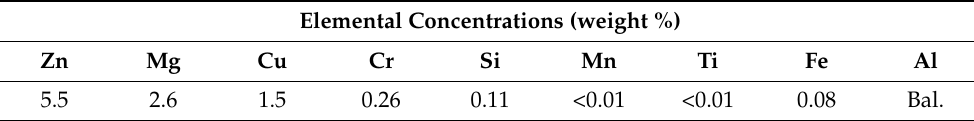
Table 1. Chemical composition of the gas atomized alloy powder